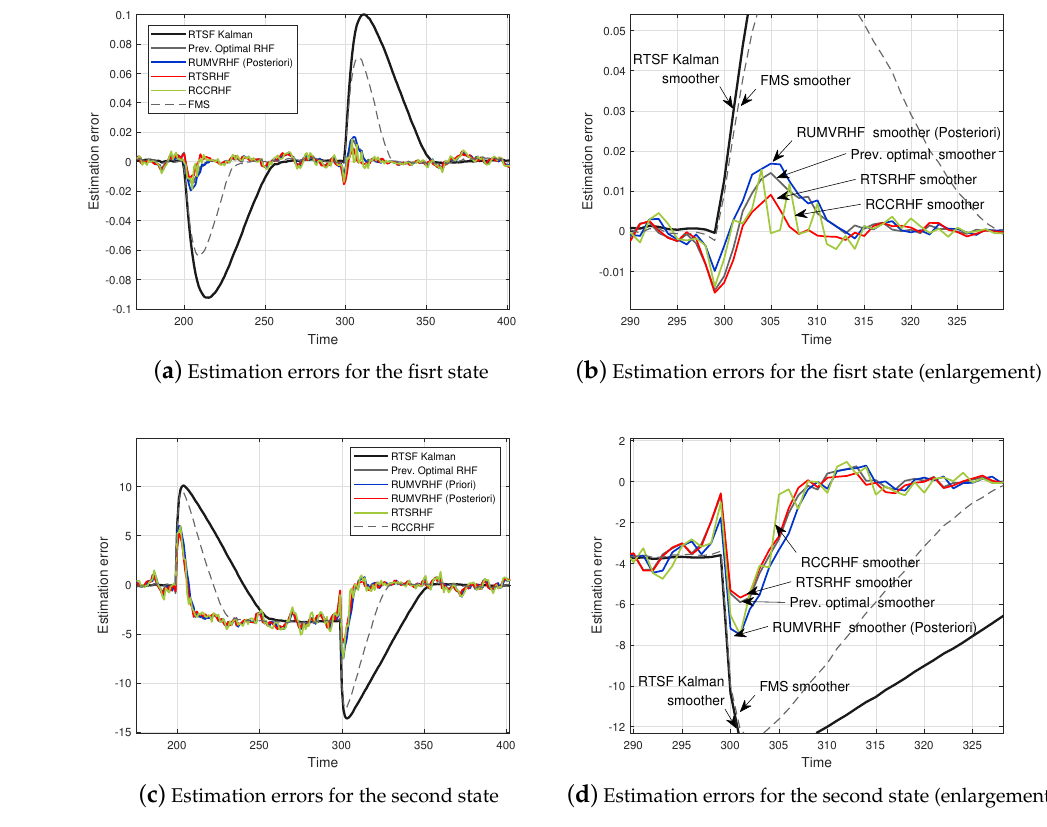
Figure 8. Estimation errors of smoothers. Table 7. Average computation times of RHF